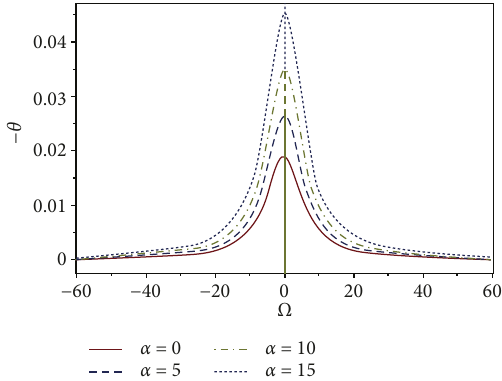
Figure 4: Universal dispersion coe ffi cient plotted against the dimensionless orthogonal fi eld, Ω , and ̂ x = 0 5 , z = − 1 , and γ = 0 5 for various values of the angle of divergence, α